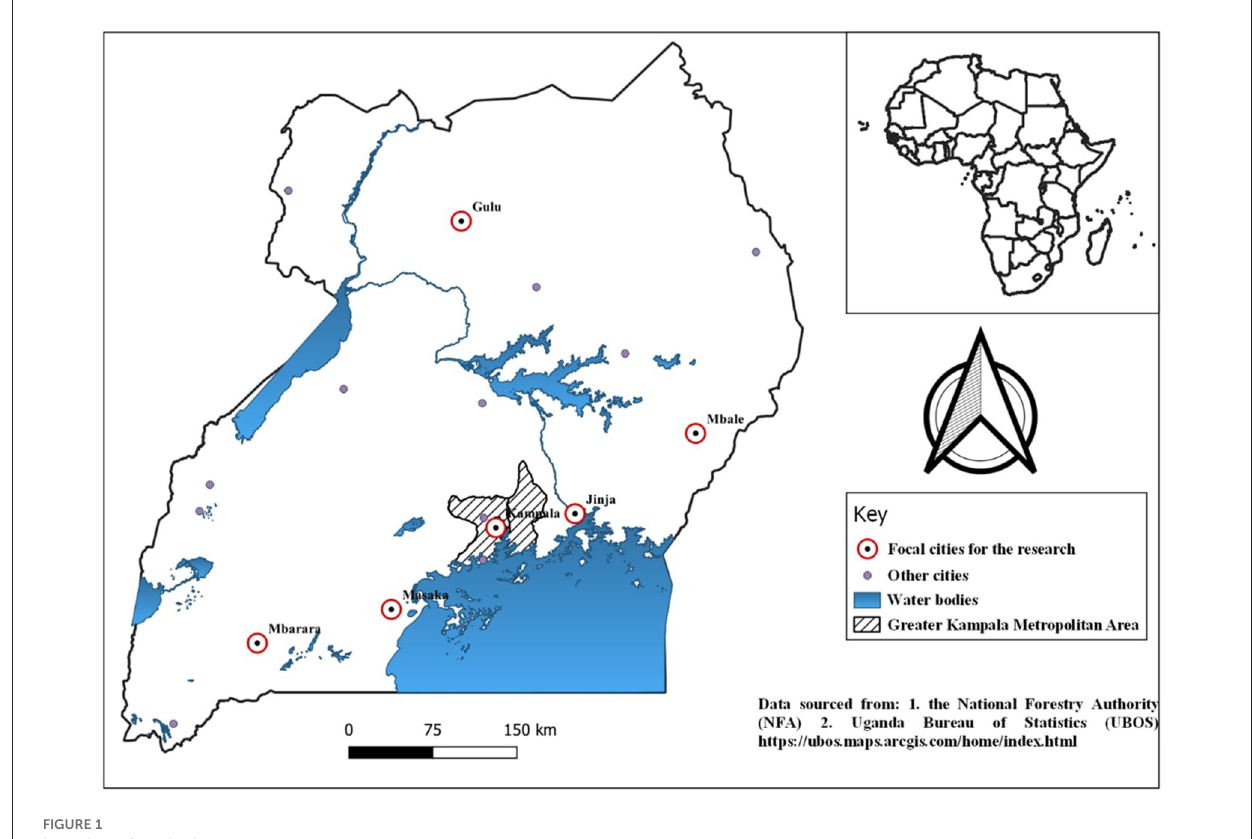
FIGURE1 Location of study sites.